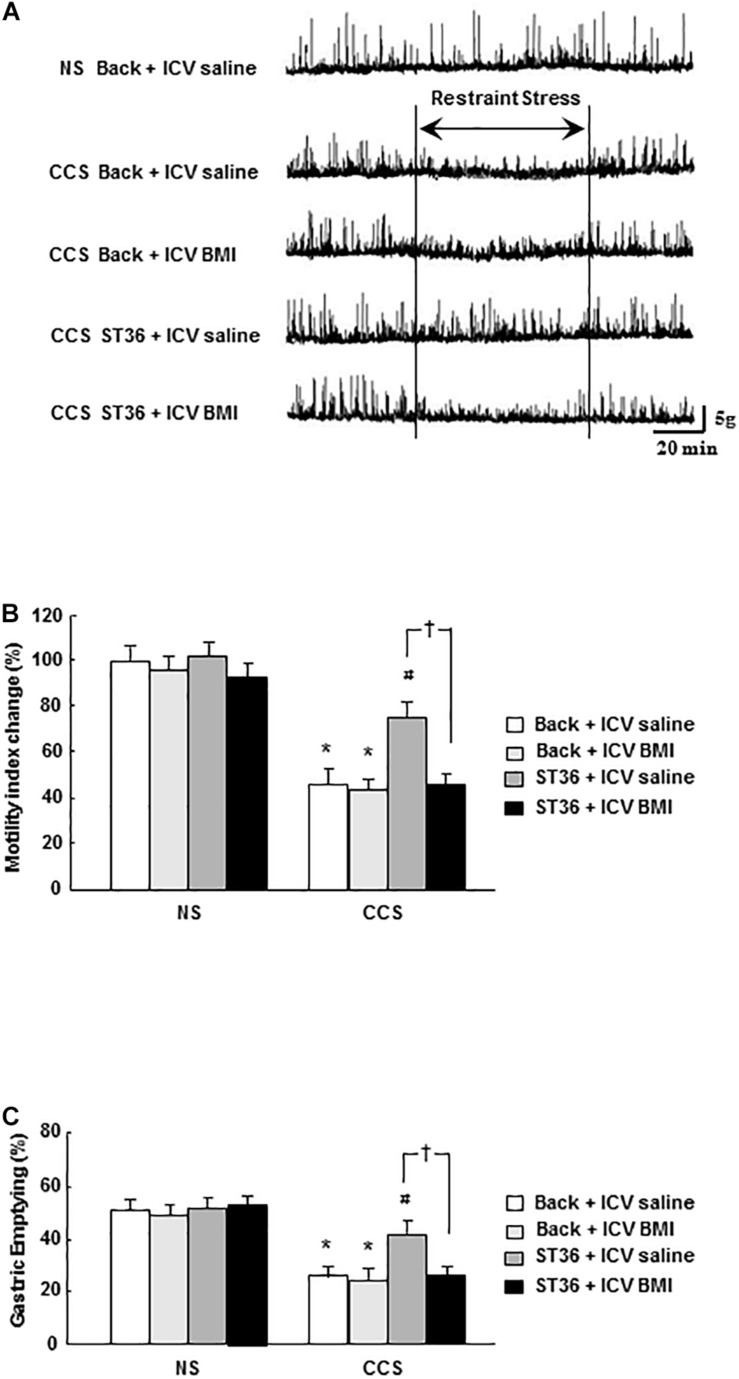
Effects of EA at ST-36 and GABAA receptor antagonist on gastric motility (A), gastric MI change (B), and GE (C) in response to CCS. (A) The gastric phase III-like contractions in the non-stressed groups (NS). EA at back (with ICV administered saline or BMI) and EA at ST-36 (with ICV administered saline or BMI) both had no effects on gastric contractions (data not shown). In the CCS conditions, CCS abolished gastric phase III-like contractions in the sham group (EA at back, and saline ICV administered). ICV injection of BMI also had no effect on the gastric contractions. However, in the EA at ST-36 groups, the partially restored gastric contraction was completely abolished by ICV administered of BMI. (B) In the NS groups, the gastric MI change showed high value. EA at back (with ICV administered saline or BMI) had no effects on the gastric MI change. However, EA at ST-36 (with ICV administered saline or BMI) also had no impacts on the gastric MI change. In the CCS conditions, CCS significantly decreased the gastric MI change in the sham group (EA at back, and saline ICV administered). ICV injection of BMI also had no effect on the gastric MI change. However, in the EA at ST-36 groups, the significantly increased gastric MI change was completely antagonized by ICV administered BMI. (C) In the NS groups, the GE showed high value. EA at back (with ICV administered saline or BMI) had no effects on the GE. However, EA at ST-36 (with ICV administered saline or BMI) also had no impacts on the GE. In the CCS conditions, CCS significantly decreased the GE in the sham group (EA at back, and saline ICV administered). ICV injection of BMI also had no effect on the GE. However, in the EA at ST-36 groups, the significantly increased GE was completely antagonized by ICV administered BMI (n = 6, *P < 0.05 compared with NS non-treated group, #P < 0.05 compared with CCS non-treated group, †P < 0.05 compared with CCS ST36 + ICV saline group).